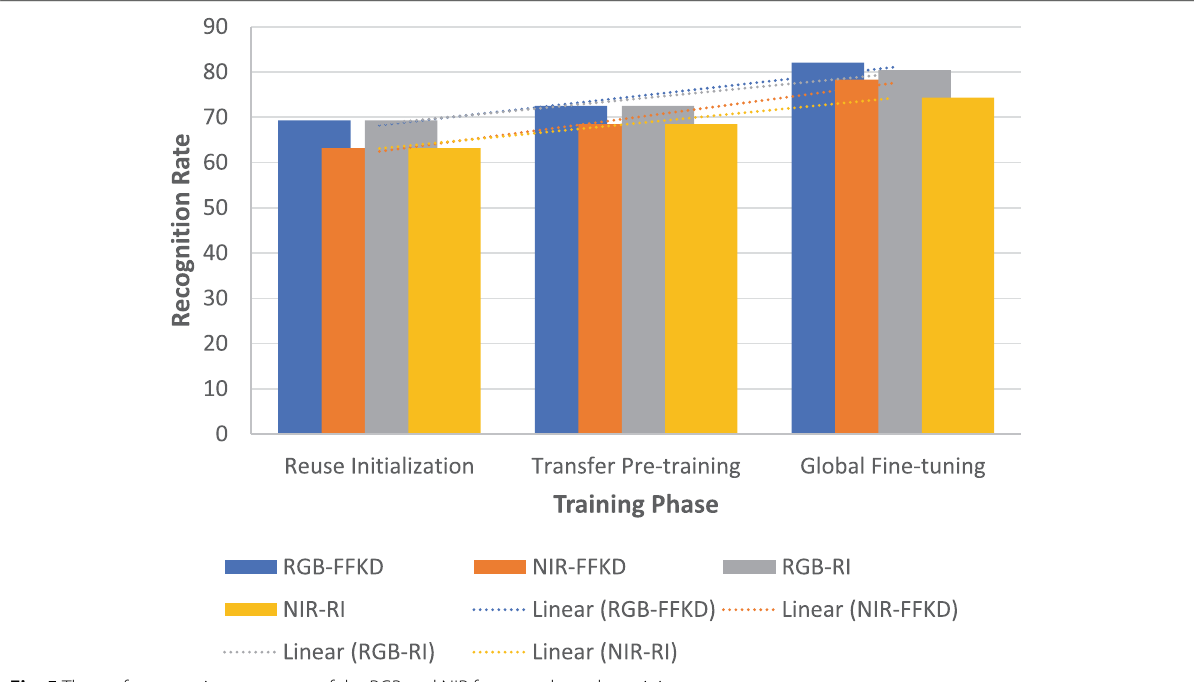
Fig. 5 The performance improvement of the RGB and NIR features along the training